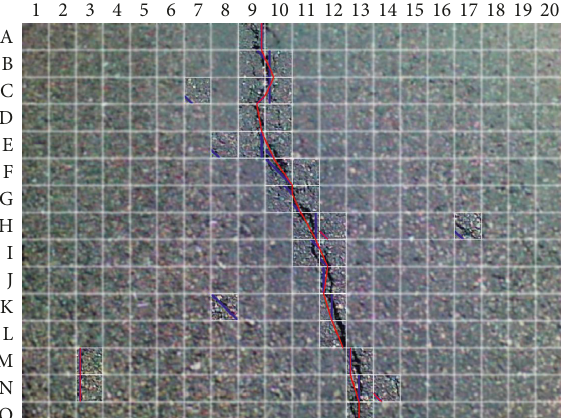
Figure 14: Blue lines show the raw mapping of the cracks. The crack map is not unified, and there are isolated mapped cracks available in the image. Red line shows the improved mapping the cracks using the CMA, isolated cracks were eliminated, and crack’s map is unified and